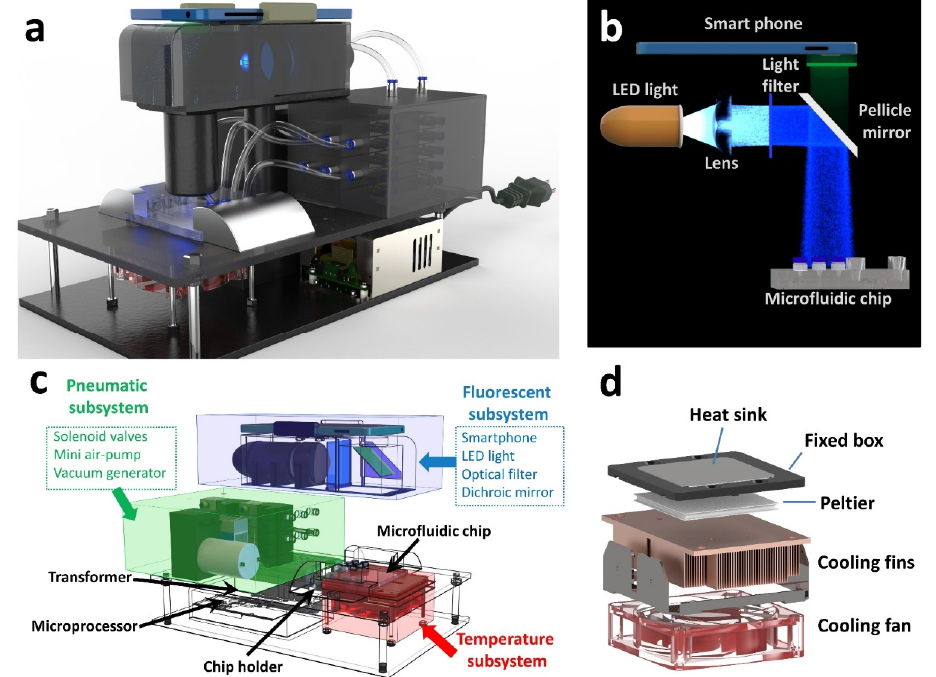
Figure 2. Point of care (POC) device design. ( a ) A stereogram of a POC device. ( b ) Schematic diagram of optical subsystem, which consists of a smartphone, a light emitting diode (LED) light, a lens, two light filters, and a pellicle mirror. After the LED light is focused by the lens and passes through the filter, a bundle of parallel exciting light is reflected by the pellicle mirror, and the returned emission light is captured by smartphone. ( c ) A perspective drawing of the POC device. Each subsystem is filled with an individual color—blue, green, and red—to correspond to fluorescent detection subsystem, pneumatic subsystem, and temperature control system, respectively. ( d ) Schematic diagram of temperature control subsystem, which consists of a heat sink, a fixed box, a Peltier element, cooling fins, and a cooling